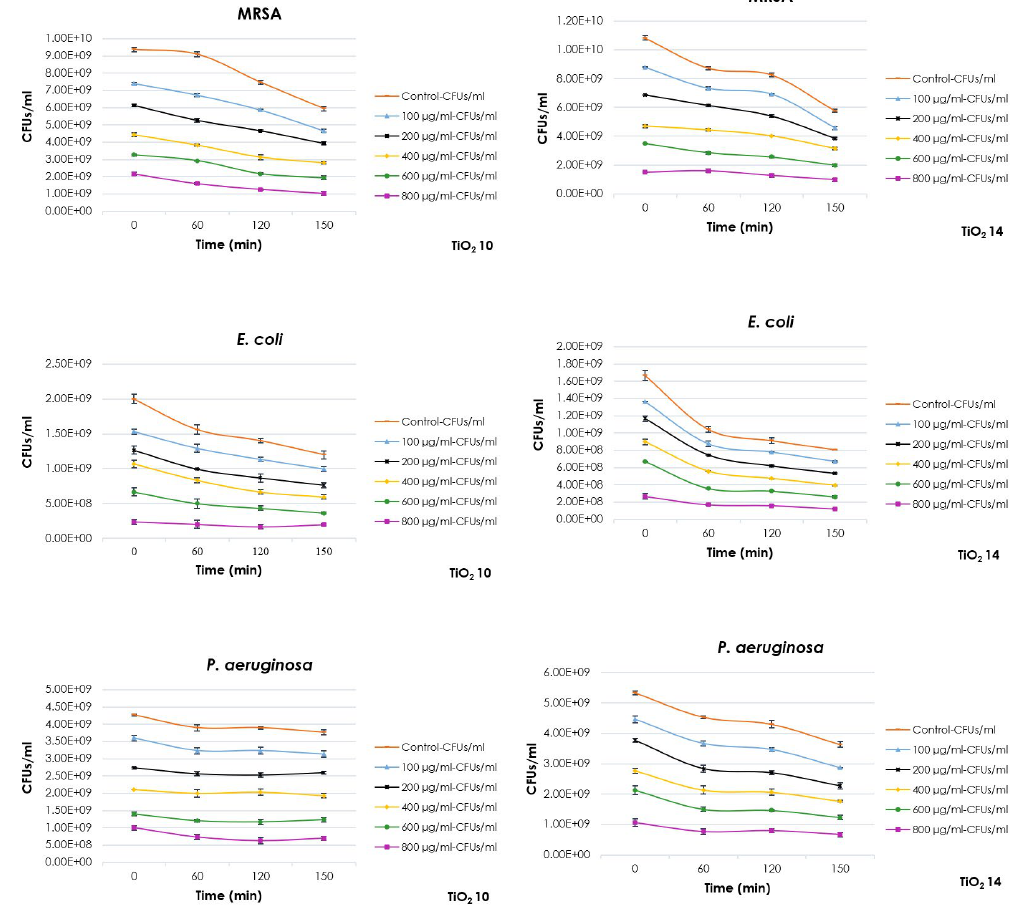
Nanoparticles with particle size less than 5 nm against MRSA, P. aeruginosa 2